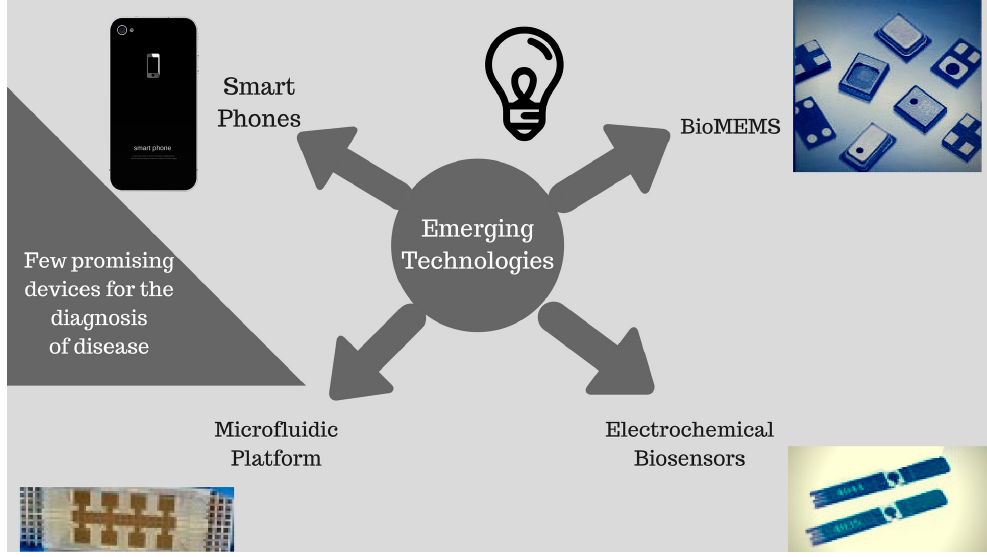
Figure 2. Illustration of a range of promising emerging methods of PoC technologies.